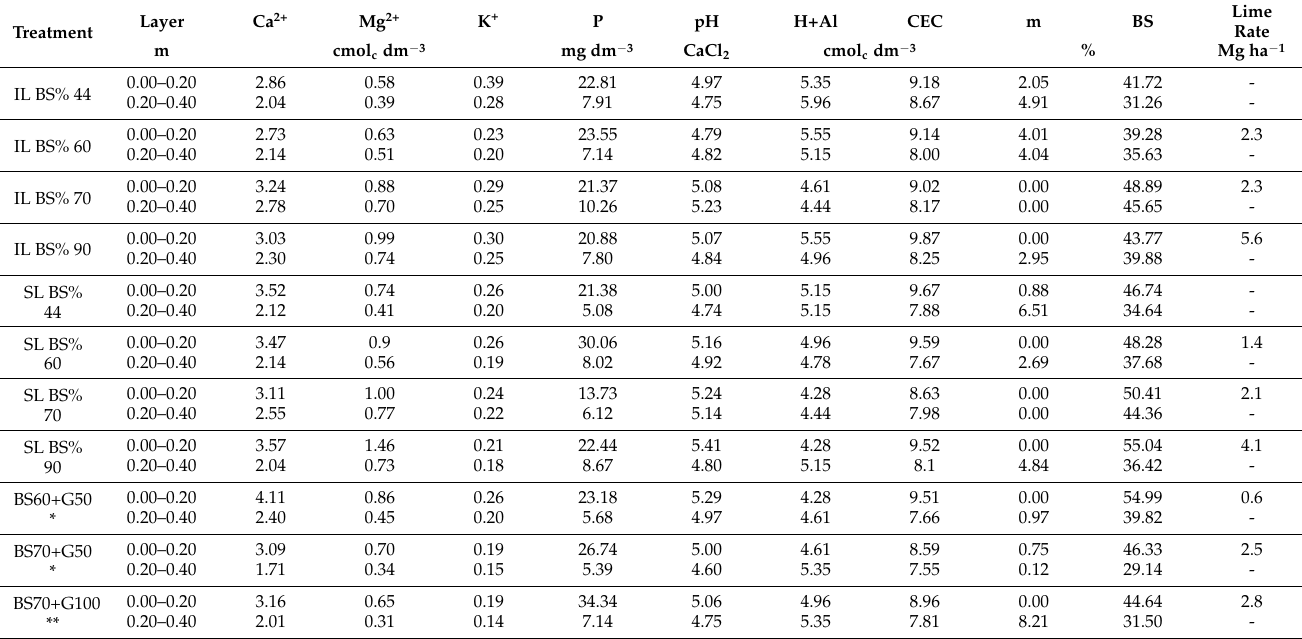
Table 1. Chemical characterization of the soil before treatment in 2016 and limestone application rates